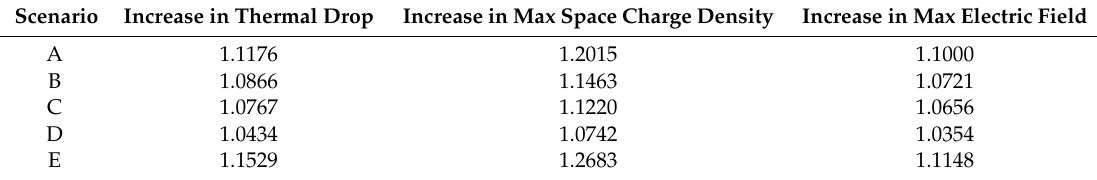
Table 5. Local increases in thermal drop, space charge density, and electric field.